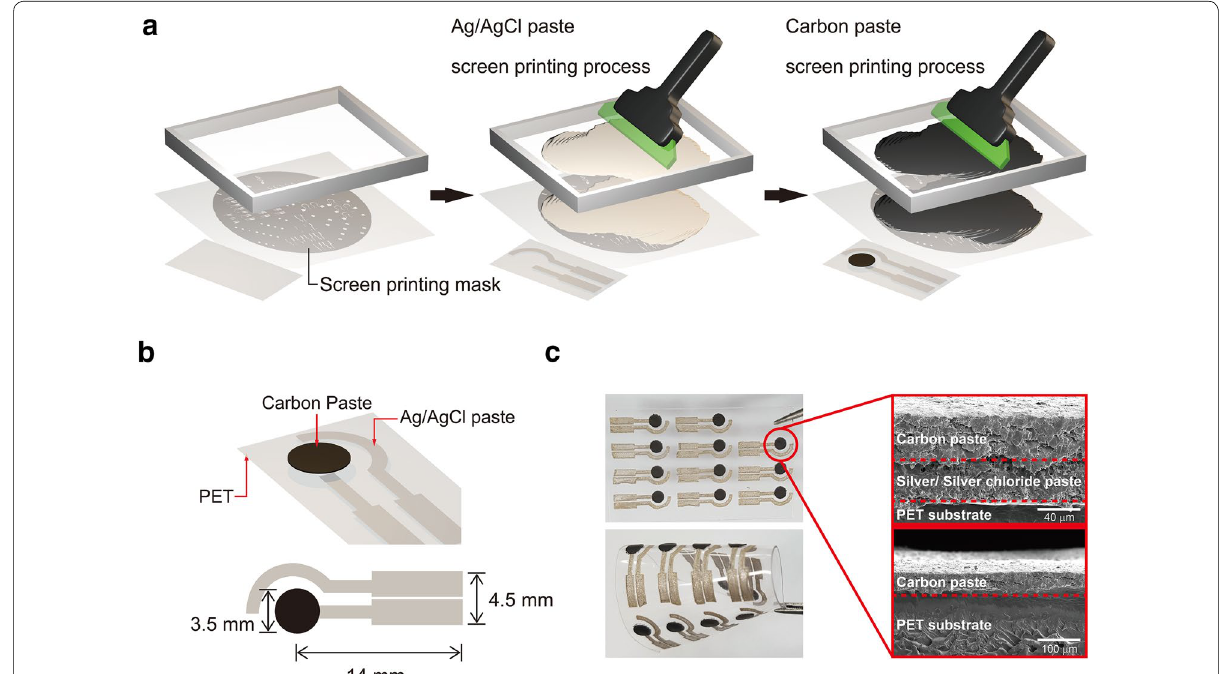
Fig. 1 a Schematic illustration of fabrication of pH sensors based on a screen printing process. b Schematic of device structure of pH sensor. c Photograph images of pH sensors under mechanically bent and normal states and cross-sectional SEM images of pH